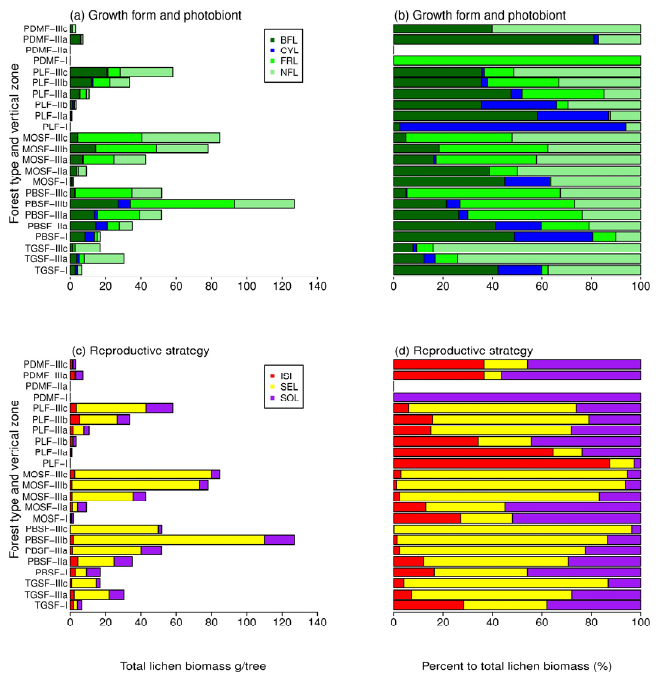
Figure 5. The biomass and percentages of epiphytic lichen groups in the vertical zones of five forest types in the Ailao Mountains, Southwest China. ( a ) biomass of lichen groups divided by growth form and photobiont; ( b ) biomass of lichen groups divided by reproductive strategy; ( c ) the percentage to total biomass of lichen groups divided by growth form and photobiont; ( d ) the percentage to total biomass of lichen groups divided by reproductive strategy. PDMF: primary dwarf mossy forest; PLF: primary Lithocarpus forest; MOSF: middle ‐ aged oak secondary forest; PBSF: Populus bonatii secondary forest; TGSF: Ternstroemia gymnanthera secondary forest. I: basal trunk; IIa: lower trunk; IIb: upper